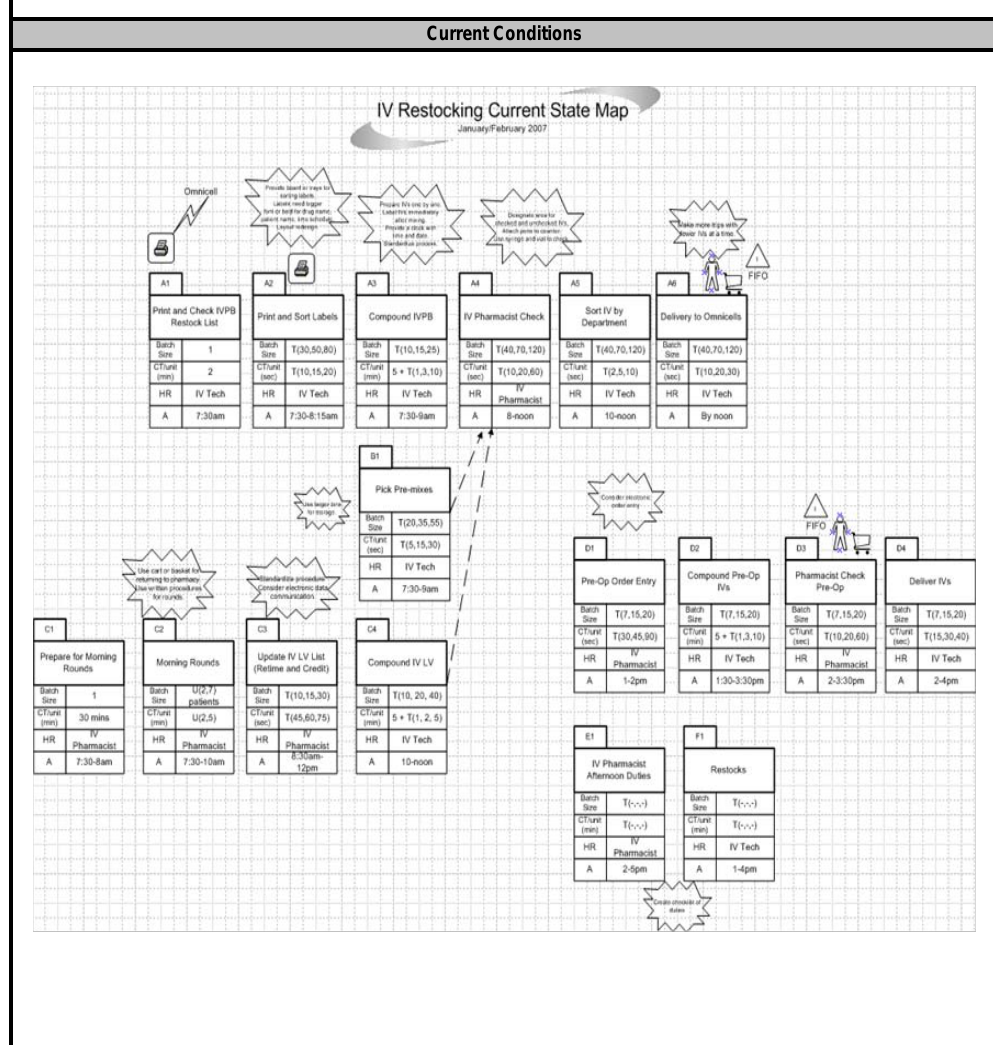
Figure 1a. “Map to Improve (M2I) Tool: Page